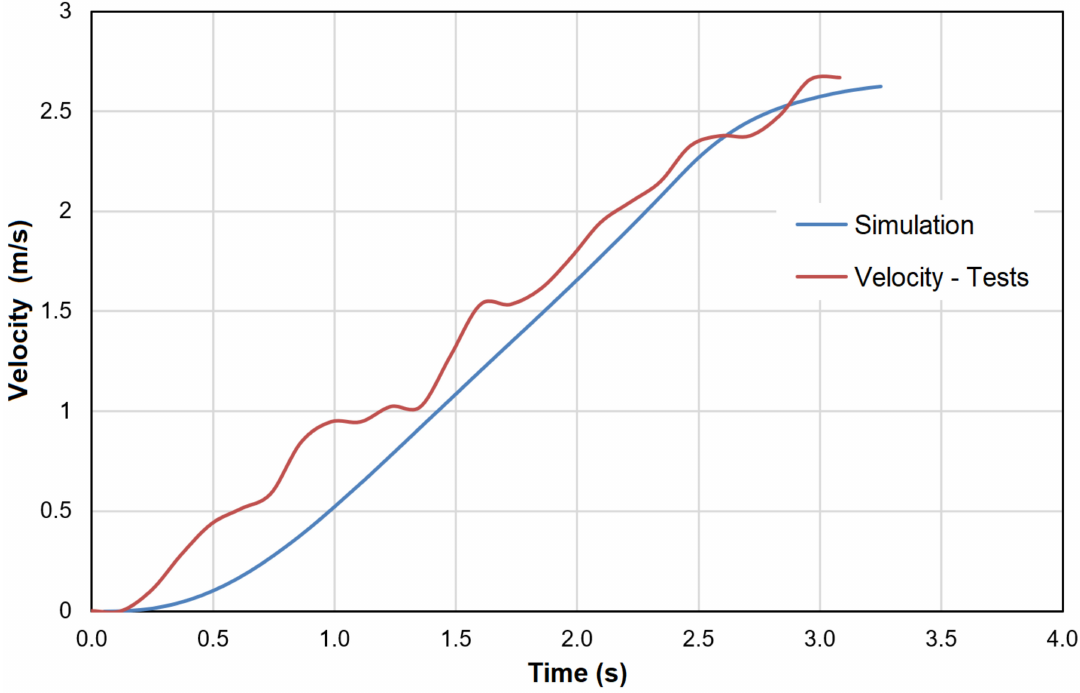
Figure 18. Comparison of velocity measurement results, and analysis of the results for the value of the working stroke s = 5.5